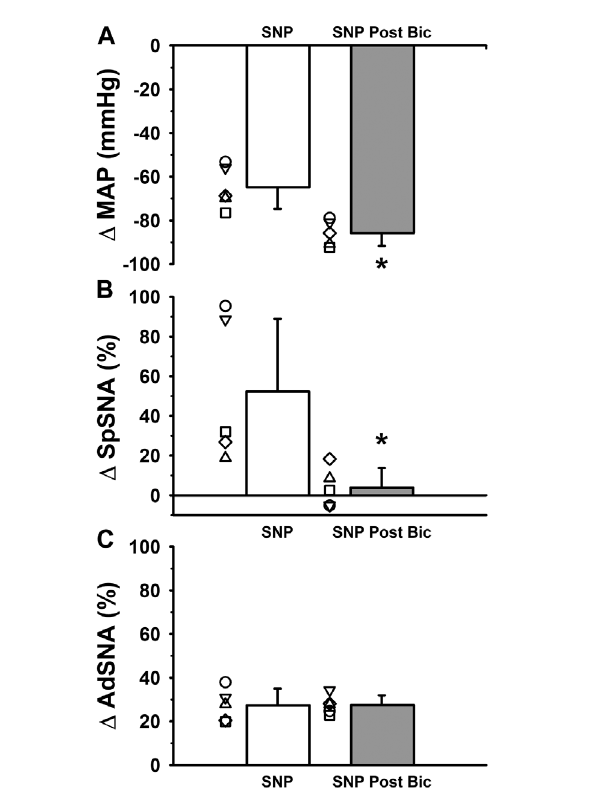
FIGURE 3 Group data from fi ve experiments in which responses to intravenous administration of sodium nitroprusside were recorded during simultaneous measurements of (A) mean arterial pressure (MAP) and (B) left SpSNA and (C) AdSNA. Averaged data from experiments in which sympathoexcitatoryresponses to intravenous administration of sodium nitroprusside (SNP) were compared under control conditions and following bilateral microinjection of the GABA A receptor antagonist, bicuculline (2 mM, 90 nL per side) into the RVLM. Intravenous SNP producedsigni fi cant decreases inMAP from baseline (Table 1; p < 0.001; main effect of glutamate). When calculated as absolute changes in MAP, the decrease in blood pressure in response to SNP was signi fi cantly greater in the presence of bicuculline compared to control conditions (Figure 3A; *, p = 0.004; paired t -test), suggesting the same dose of SNP produced enhanced depressor responses, likely due to a reduced capacity to re fl exively increase sympathetic activity in at least some vascular beds (see below). SNP-inducedchanges inSpSNA calculated as percent change were signi fi cantly reversed when measured in the presence of bicuculline when compared to control conditions (Figure 3B; *, p = 0.021; paired t -test). In contrast, SNP-induced increases in AdSNA calculated as percent change were not signi fi cantly different measured in the presence of bicuculline and compared to control conditions (Figure 3C, p = 0.969; paired t -test). Abbreviations as de fi ned in Figure 1